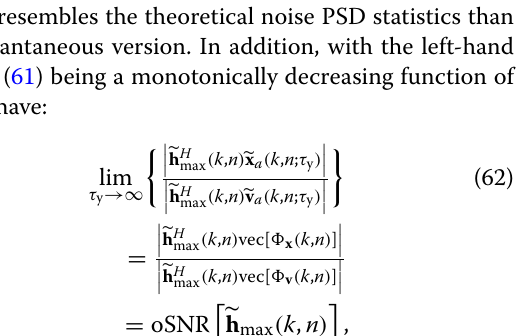
meaning that the temporal smoothing step does not